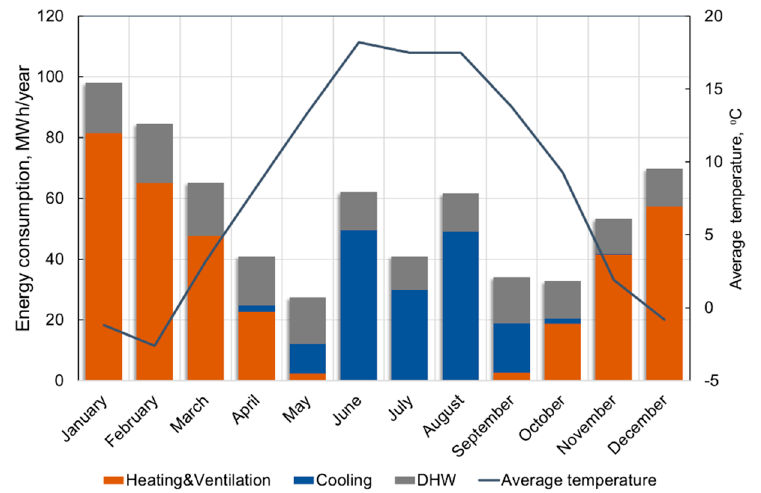
Figure 5. Monthly energy consumption by system and distribution of average outdoor temperature over the year.